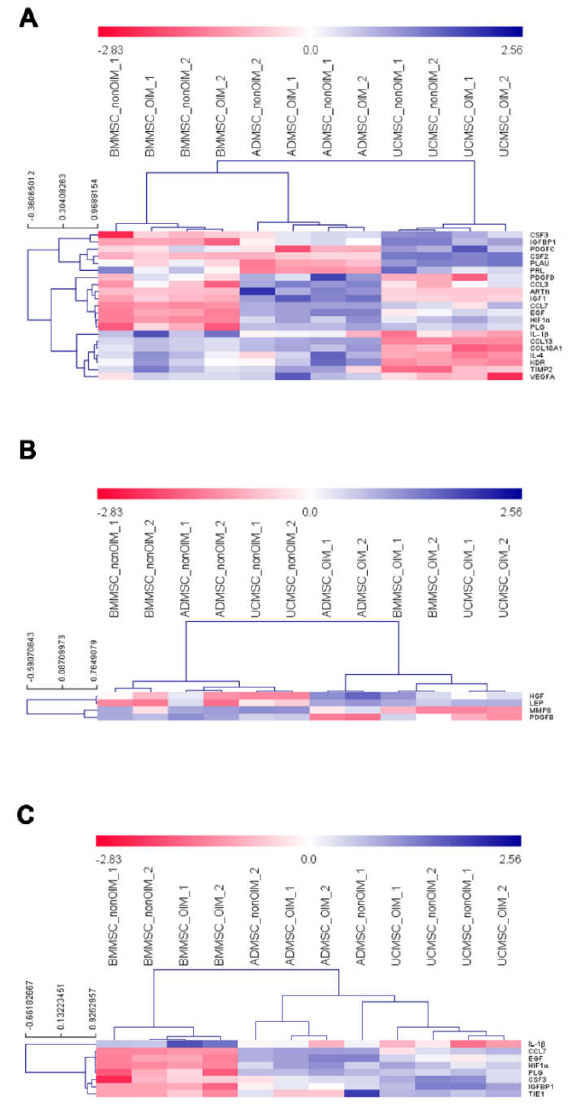
Figure 5. Differentially expressed gene analyses. ( A ) A one-way ANOVA analysis showed the differentially expressed genes among MSCs from different sources. Permutations (1000), Pearson correlation, HCL clustering with average linkage, and p -value < 0.01 were used. ( B ) A t -test examined the differentially expressed genes between nonOIM and OIM samples. A p -value < 0.01 was used. ( C ) A t -test explored the differentially expressed genes between BMMSCs and the other two MSCs. A p -value < 0.01 was used. Red and blue colors represent high and low gene expression levels,